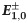
Numerical details about the analytical solutions E1,0±.a) Region in the parameter space (cosθ1, cosθ2, E1,0) in which both solutions E1,0± satisfy the physical constrain 0 < E1 < 1. b) Region in the parameter space (cosθ1, cosθ2, E1,0) in which solution E1,0+ applies. c) Region in the parameter space (θ1/θ2, θ2, E1,0) in which solution E1,0+ applies. d) Family of curves parametrized by E1,0 (ranging from 0 [black] to 1 [light gray] in step of 0.1) that pose an upper limit to θ1/θ2 for E1,0+ to be acceptable. The red curve corresponds to E1,0 = e−1 and entirely lies in the half-plane θ1/θ2 > 0.47.